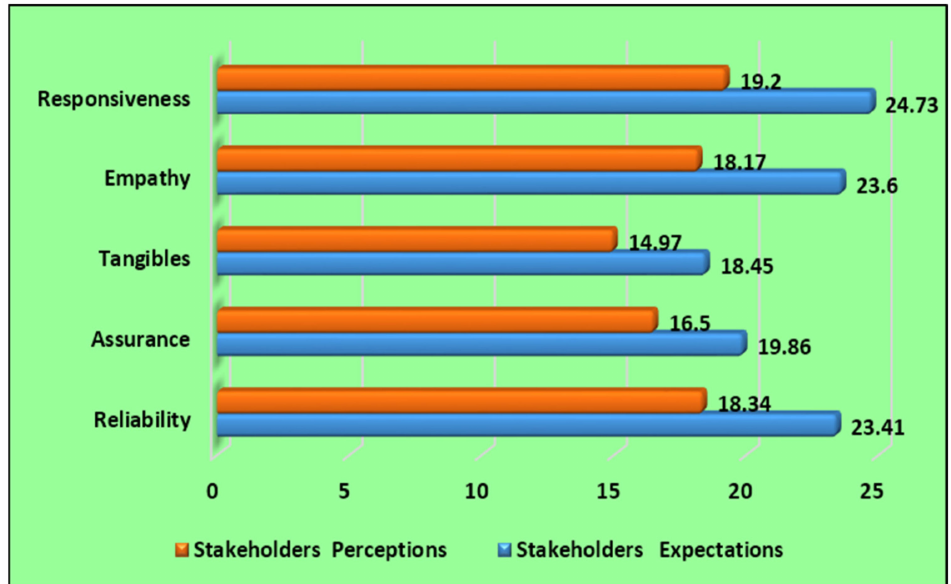
Figure 6. Expectations and perceptions of tourism stakeholders about IoT as a sustainable energy management solution at tourism destinations (pictures 1–5 showing mean scores for Reliability, Assurance, Tangibles, Empathy, and